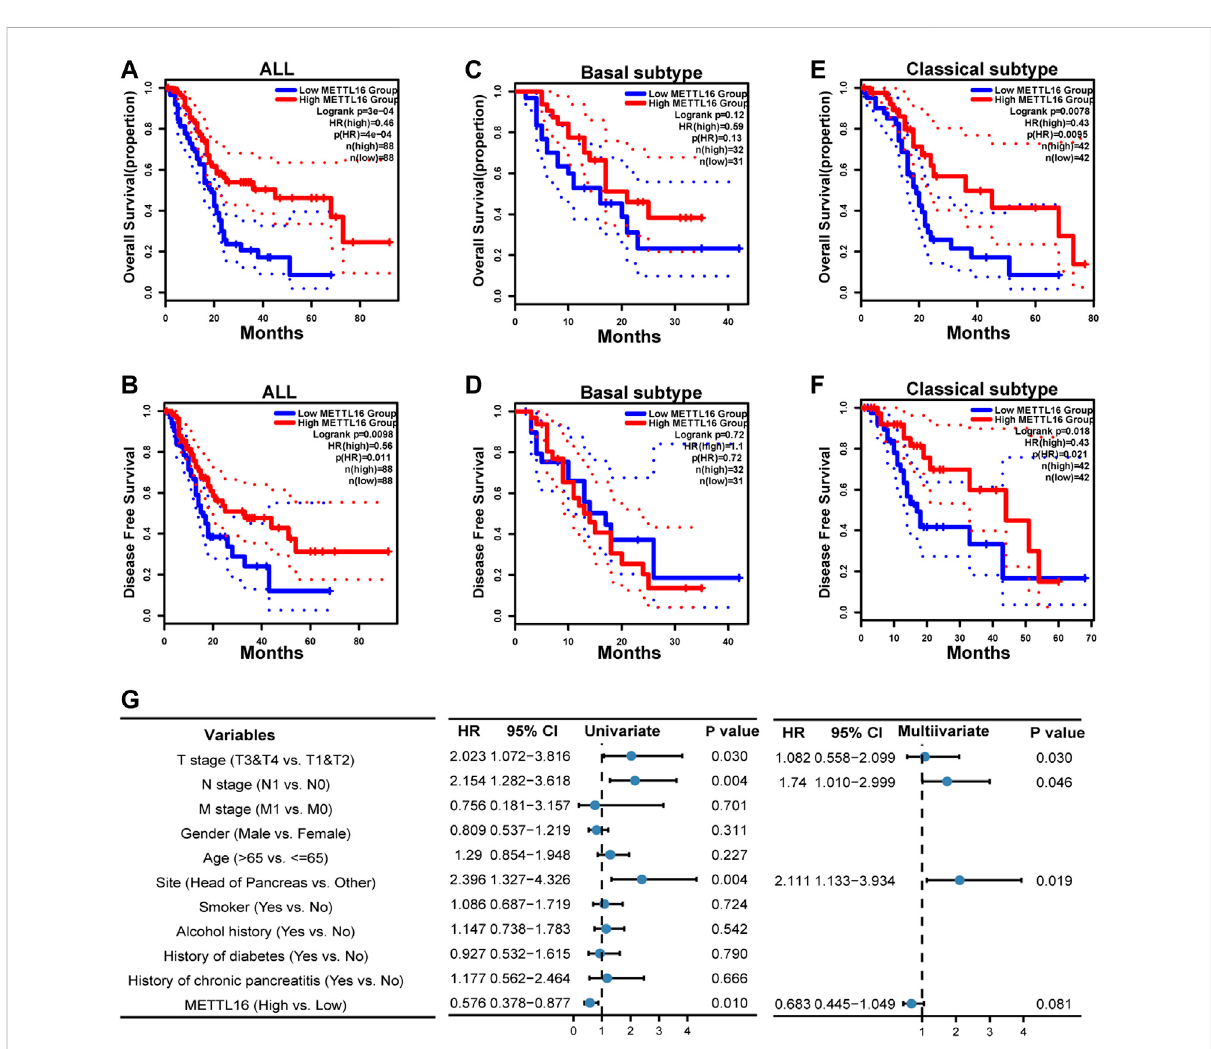
FIGURE 3 Favorable prognostic value of METTL16 in PDA. (A,B) Overall survival (OS) (A) and disease-free survival (DFS) (B) of all PDA patients in the TCGA cohort according to METTL16 expression. The red line represented the METTL16 high-expression group in the TCGA-PAAD cohort. The blue line showed the METTL16 low-expression group. The dotted line indicated 95% CI of the survival curves. (C,D) There was no signi fi cant difference in OS (C) or DFS (D) between the METTL16 high- and low-expressiongroups of PDA patients with basal subtype. (E,F) Longer OS (E) and DFS (F) were observed for PDA patients with classical subtype in the METTL16 high-expression group. (G) Univariate and multivariate Cox regression analyses of associations between METTL16 expression and clinicopathological characters in PDA